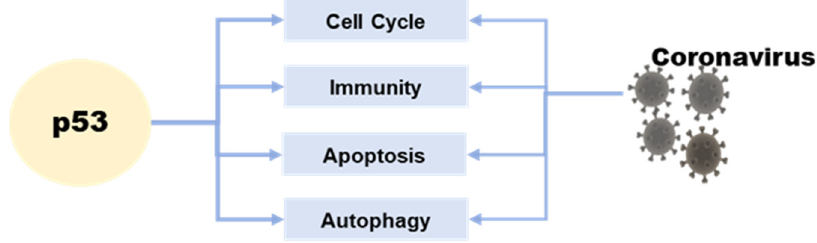
Figure 1. The relationship between p53 and